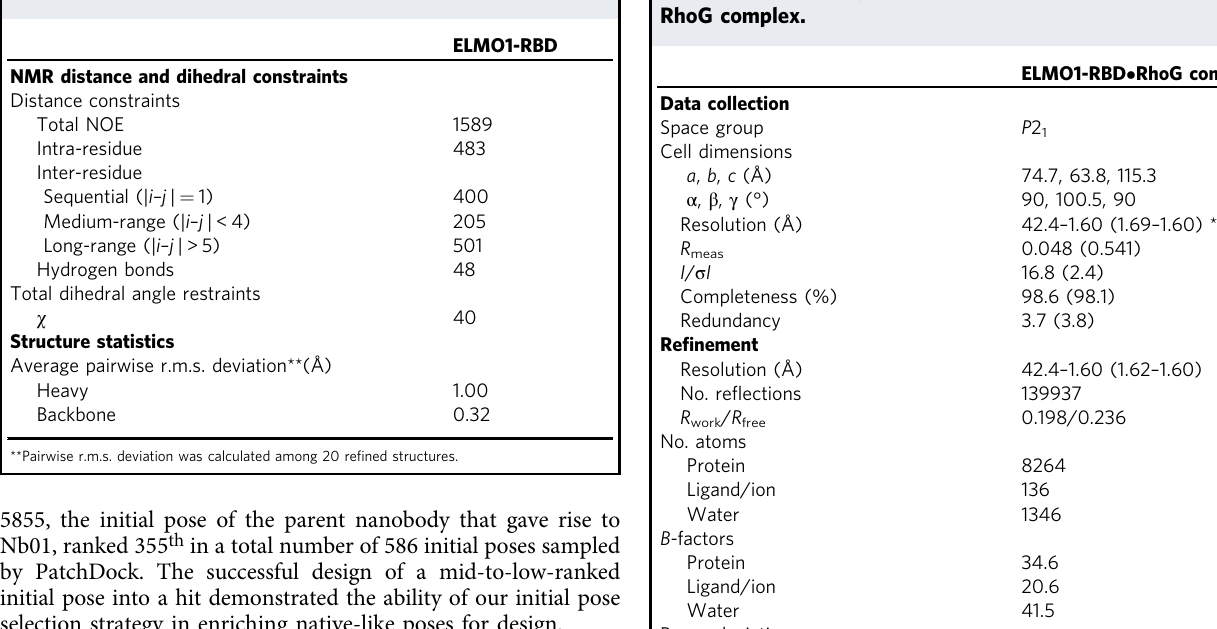
Table 1 NMR and re fi nement statistics for